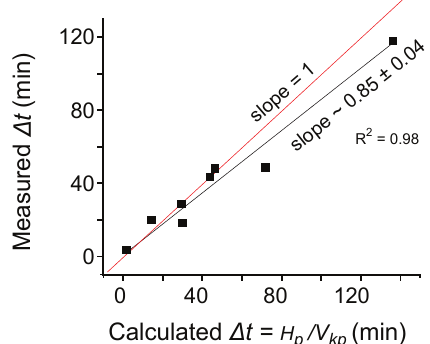
Figure 9. Comparison of the measured period between knickpoints ( (cid:49)t ) to the calculated period between knickpoints using Eq. (4). Linear fit of the data is shown in